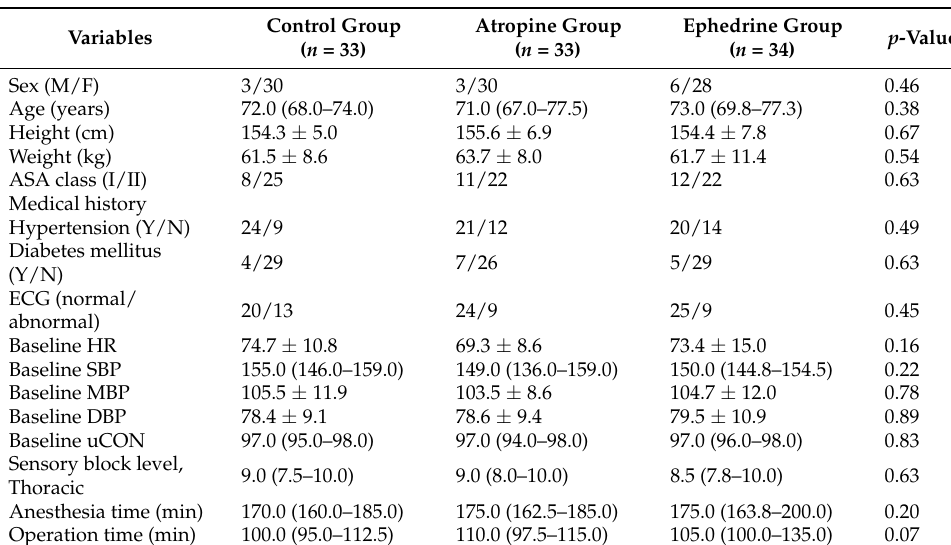
Figure 1. CONSORT flow diagram of recruitment and assessment of study participants. Table 1. Patient characteristics and clinical